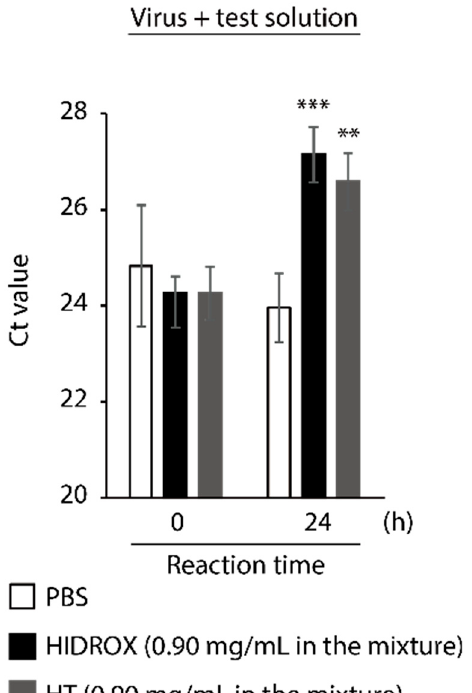
Figure 5. Impact of hydroxytyrosol (HT)-rich aqueous olive pulp extract (HIDROX) and HT on severe acute respiratory syndrome coronavirus 2 (SARS-CoV-2) genome. SARS-CoV-2 was mixed with HIDROX or HT. The final concentrations of HIDROX and HT in the mixture were 0.90 mg/mL. As a diluent control, PBS was mixed with the viral suspension. The mixtures were incubated at 25 ◦ C for 0 (no reaction time) or 24 h. Then real-time RT-PCR was performed and Ct value was evaluated. Results are indicated as mean ± SD ( n = 4 per group). Student’s t -test was performed to evaluate the statistically significant difference between the PBS group and each test solution group; ** p < 0.01; *** p < 0.001.